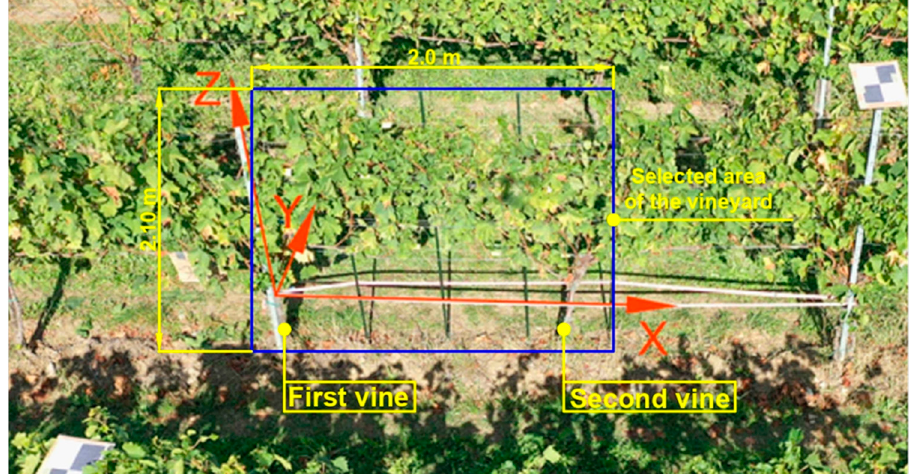
Figure 4. A (blue) section of the vineyard used for manual defoliation measurements, with local coordinate system ( X , Y , Z ). The green vertical poles and the red ribbon (collinear with x) can be seen; the horizontal ropes were somewhat hidden by the leaves.